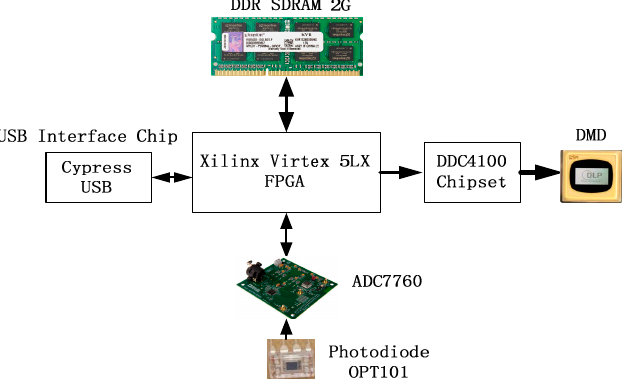
Figure 5. The diagram of single pixel camera.